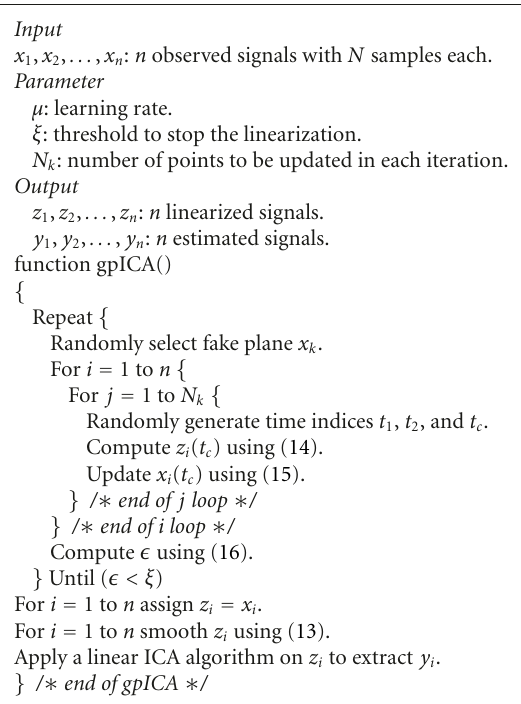
Algorithm 1: The Geometric PNL Algorithm: